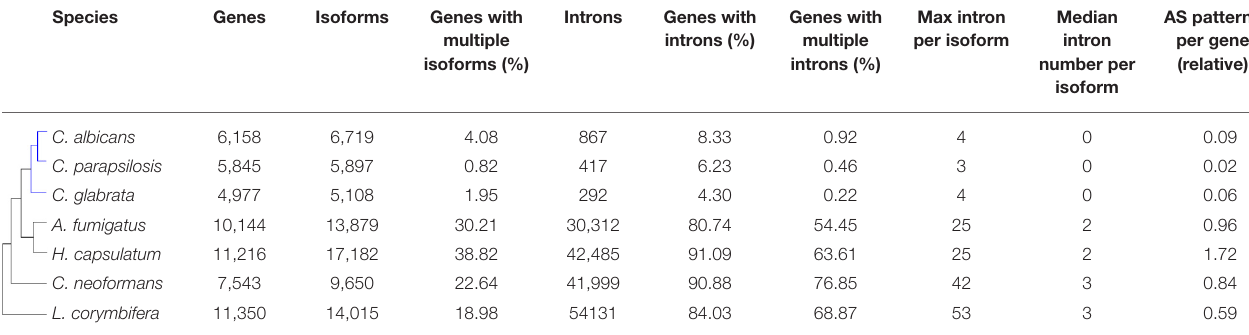
TABLE 1 | Statistical comparison of predicted and annotated isoforms for the investigated fungal species. Species Genes Isoforms Genes with